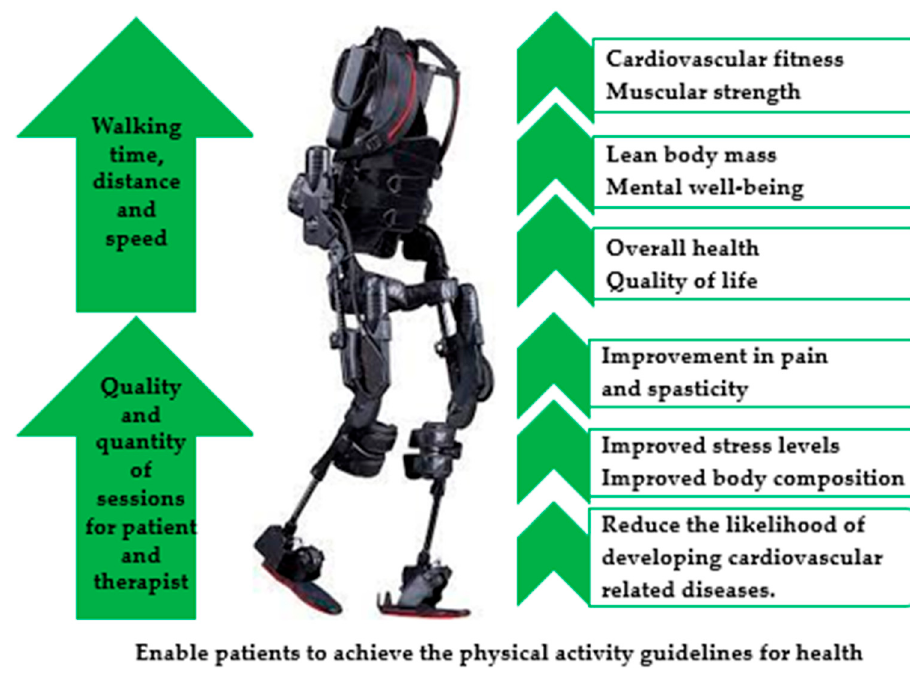
Figure 1. Benefits of powered exoskeleton gait training.